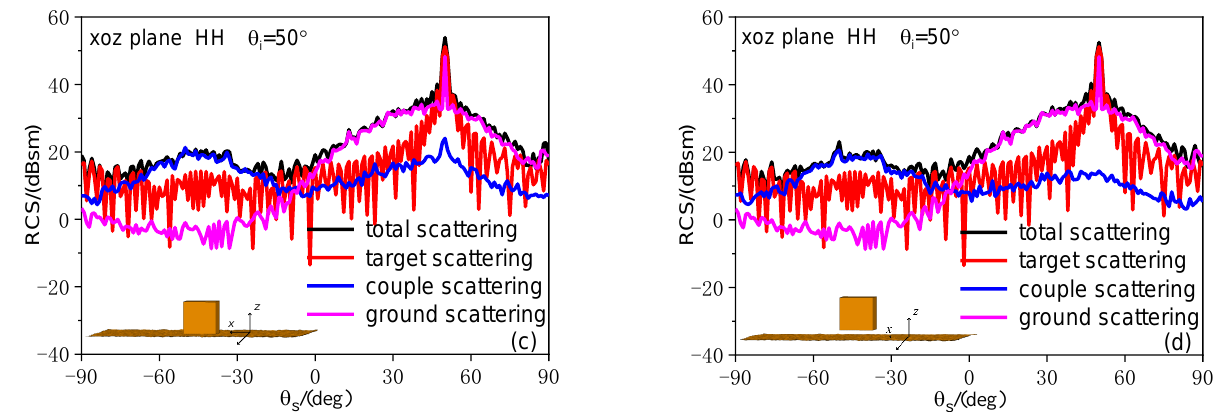
Figure 11. Bistatic scattering of cube on and above the rough ground using our method ( a ) on the rough ground θ i = 30 ◦ VV; ( b ) 1 m above the rough ground θ i = 30 ◦ VV; ( c ) on the rough ground θ i = 50 ◦ HH; ( d ) 1 m above the rough ground θ i = 50 ◦ HH. In Figure 12, the bistatic EM scattering of a full-scale antiaircraft gun on rough ground is investigated for the VV polarization, where the incident parameters are = and 3 GH z f = . The parameters of the rough ground are the same as those in 50 i Figure 11. The four types of RCS are also demonstrated in Figure 12. Compared with the result in Figure 11, the scattering of the target shows a significant enhancement for most scattered angles, which is due to the strong scattering from the complex target.